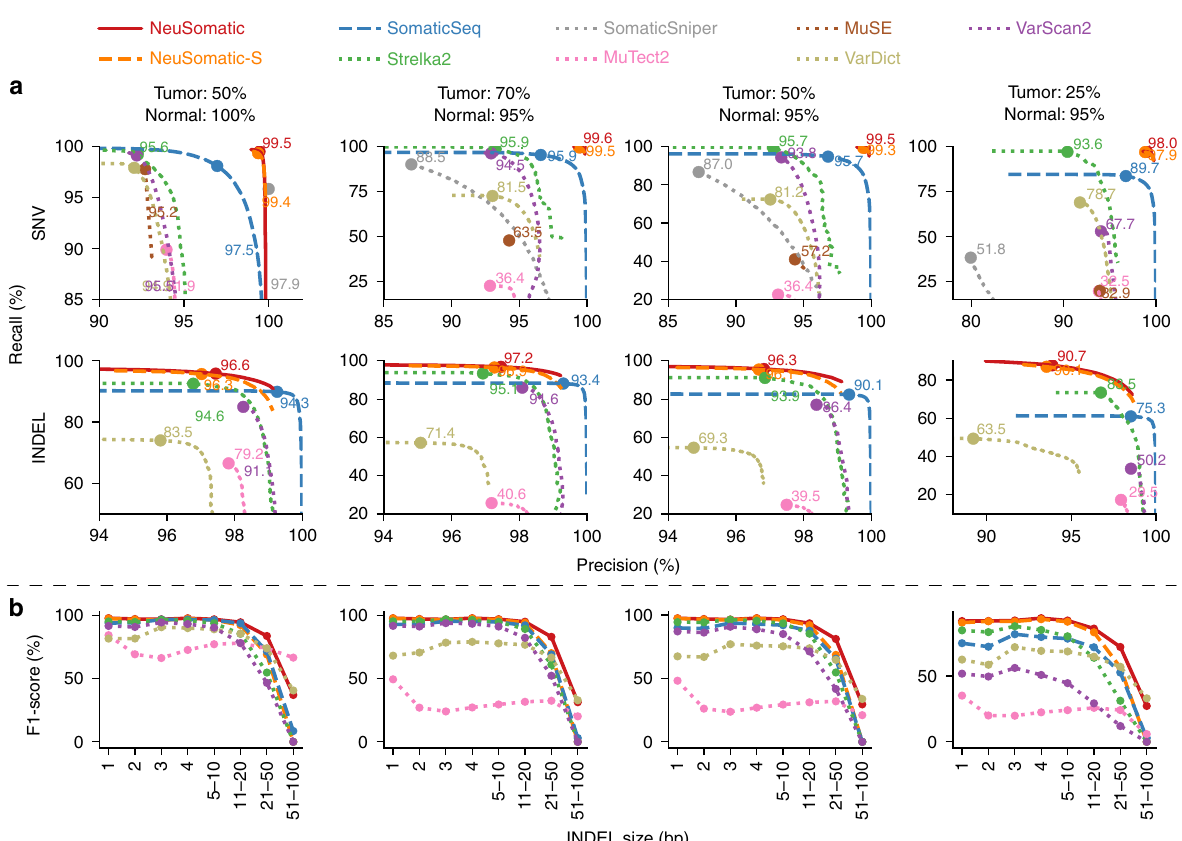
Fig. 2 Performance analysis of the Platinum two sample mixture dataset. In this dataset, four tumor and normal purity scenarios (50% T:100% N, 70% T:95% N, 50% T:95% N, and 25% T:95% N) are used. a Precision-recall analysis: the con fi dence or quality scores are used to derive the precision-recall curves. The highest F1-score achieved by each algorithm is printed on the curve and marked with a solid circle. b Performance analysis of INDEL accuracy (F1-score) for different INDEL